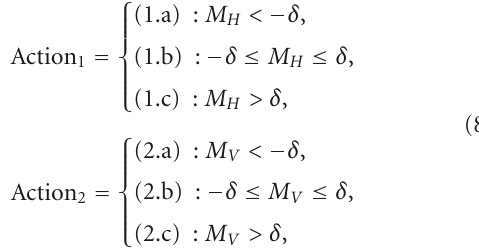
hand side ROI boundary, M U is the vertical motion of the topmost boundary, and M D denotes the vertical motion of the bottom boundary. M H is the overall horizontal motion and M V is the overall vertical